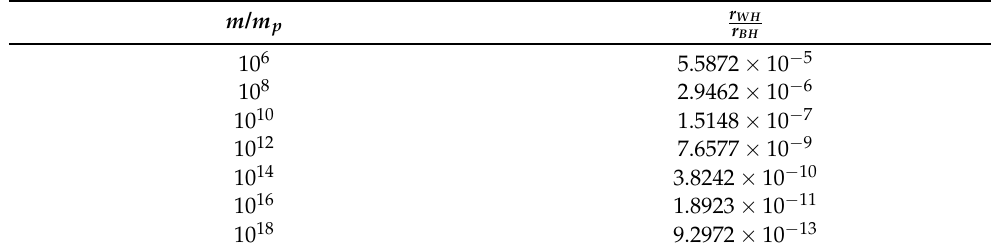
Table 2. The ratio of the WH and BH horizon radii for the case α 1 = 0 with different choices of the mass parameter m . Here we use the same choices as those in Figure 8, except for m . m / m